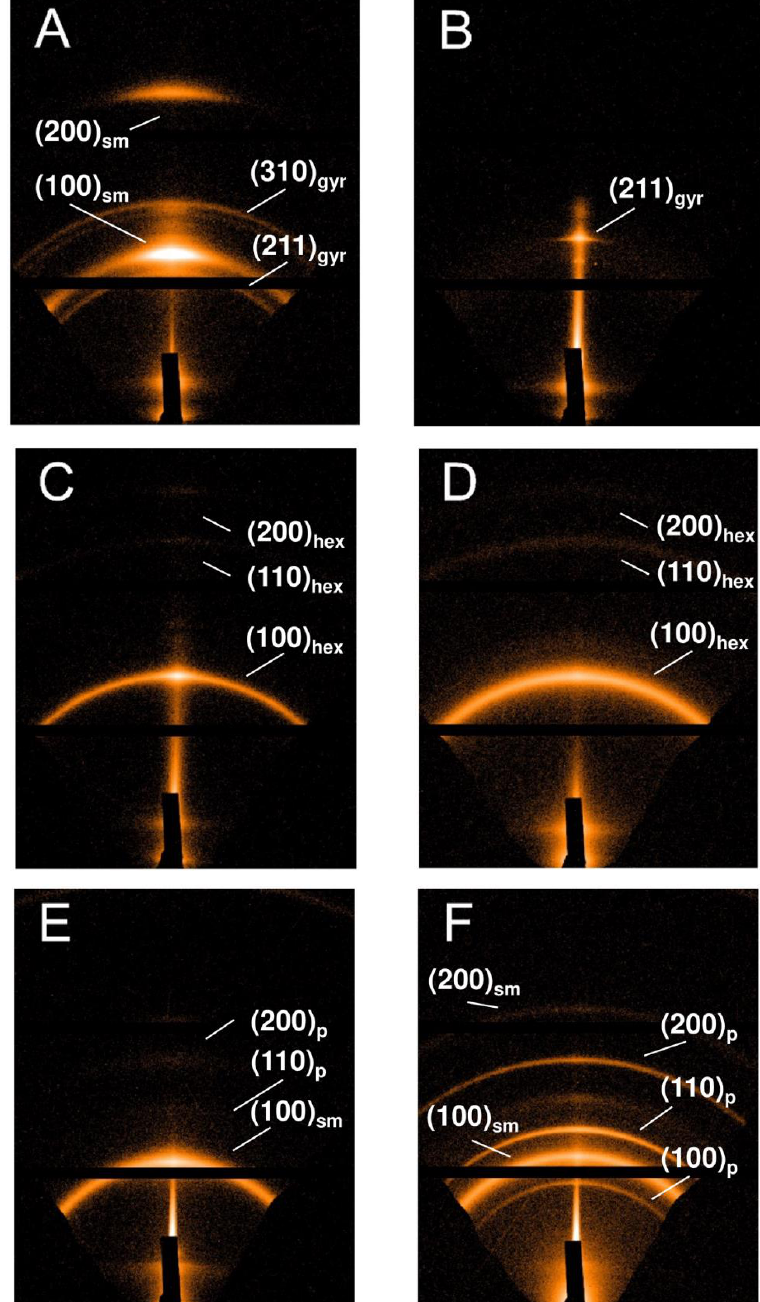
Figure 4. 2D GIXD patterns of TDOBSH ( A , B ), TDOBSNa ( C , D ) and TDOBSPyr ( E , F ) before ( A , C , E ) and after ( B , D , F ) annealing. The most intense reflections are marked with white arrows and indexed according to smectic (sm), gyroid (gyr), columnar hexagonal (hex) and cubic primitive (p) phases. The film was oriented horizontally. The black regions appear after background substruction.